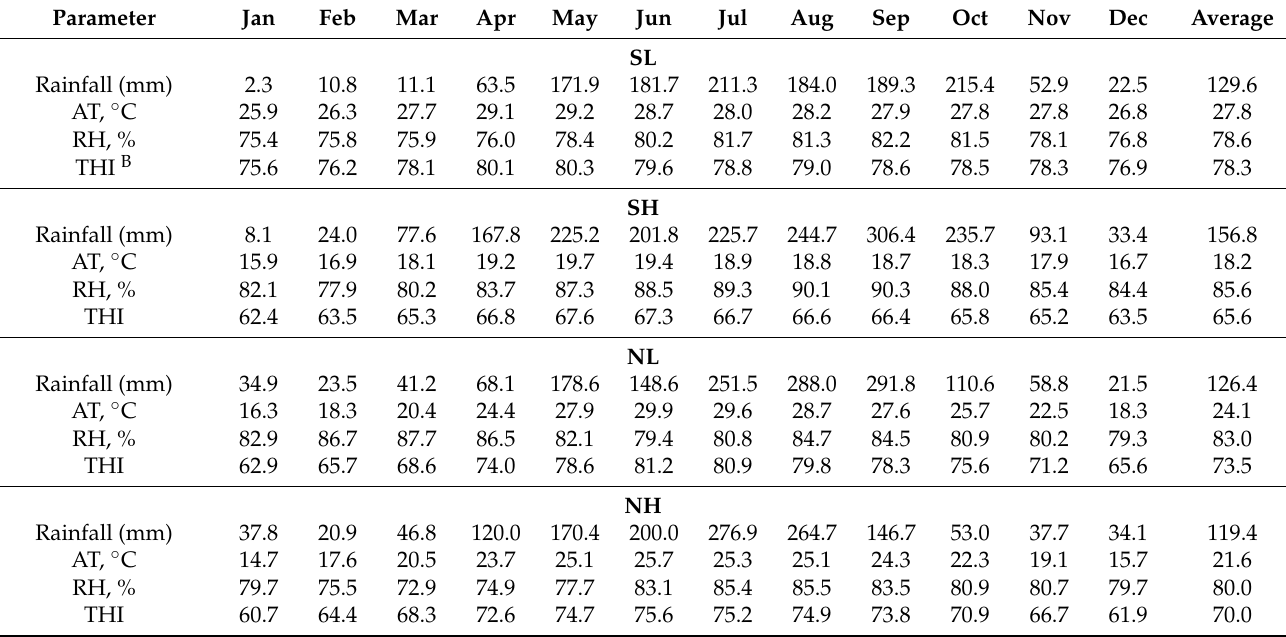
Table 1. Average monthly rainfall, temperature (AT), humidity (RH) and temperature-humidity index (THI) during a period from 2002 to 2016 at weather stations nearest to studied regions A .